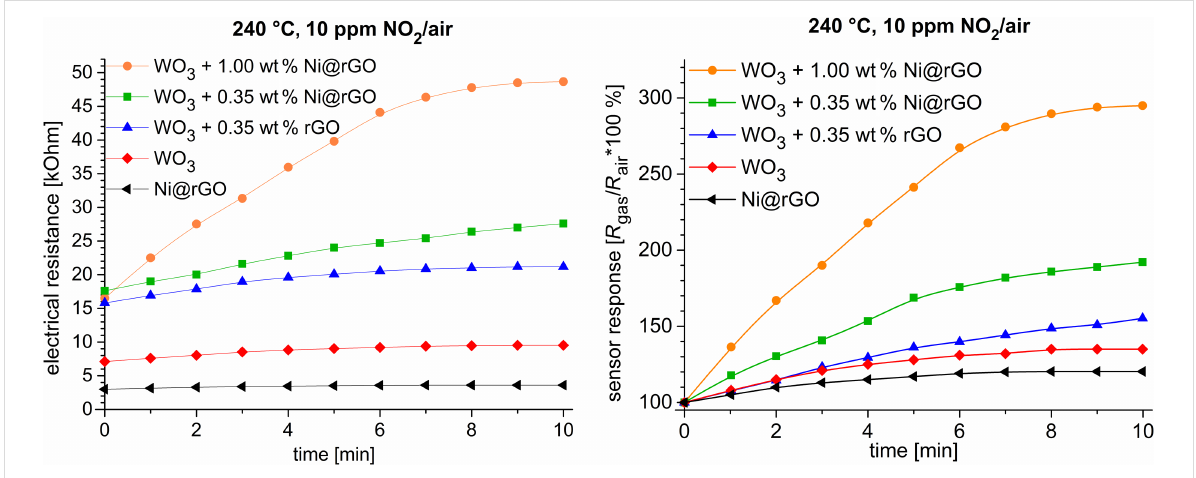
Figure 6: Time dependence of the sensor resistance values (left) and sensor response (right) of 1.00 wt % Ni@rGO + WO 3 (orange), 0.35 wt % Ni@rGO + WO 3 (green), 0.35 wt % rGO + WO 3 (blue), WO 3 (red), and Ni@rGO (black) samples under exposure to a gas mixture containing 10 ppm NO 2 in